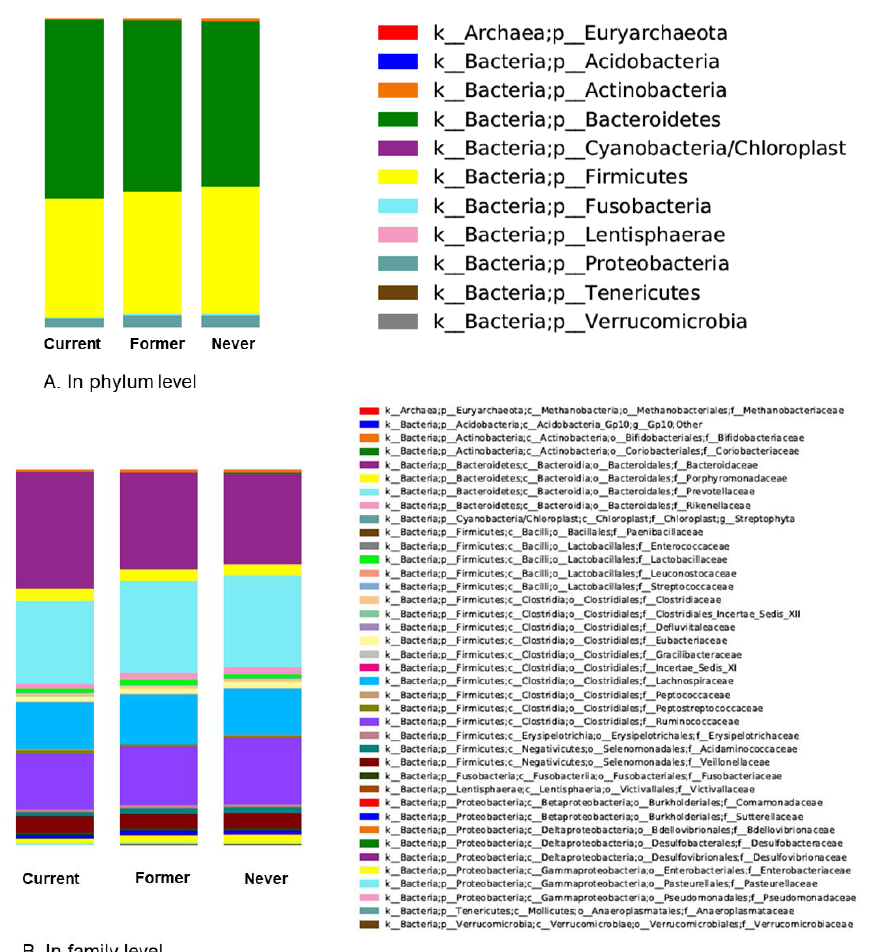
Figure 3. Bar chart of proportional abundance of phylum ( A ) and family ( B ) levels in the three smoking